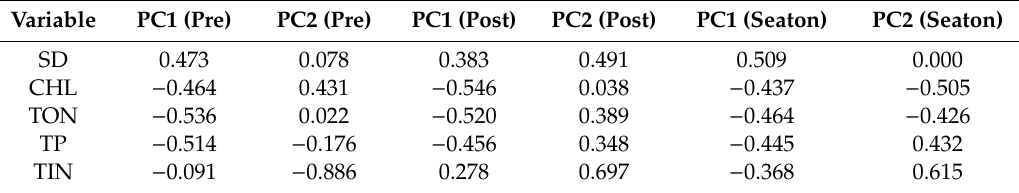
Table 2. The loading vectors for principal component (PC)1 and PC2 for Pre-, Post-diversion and Seaton